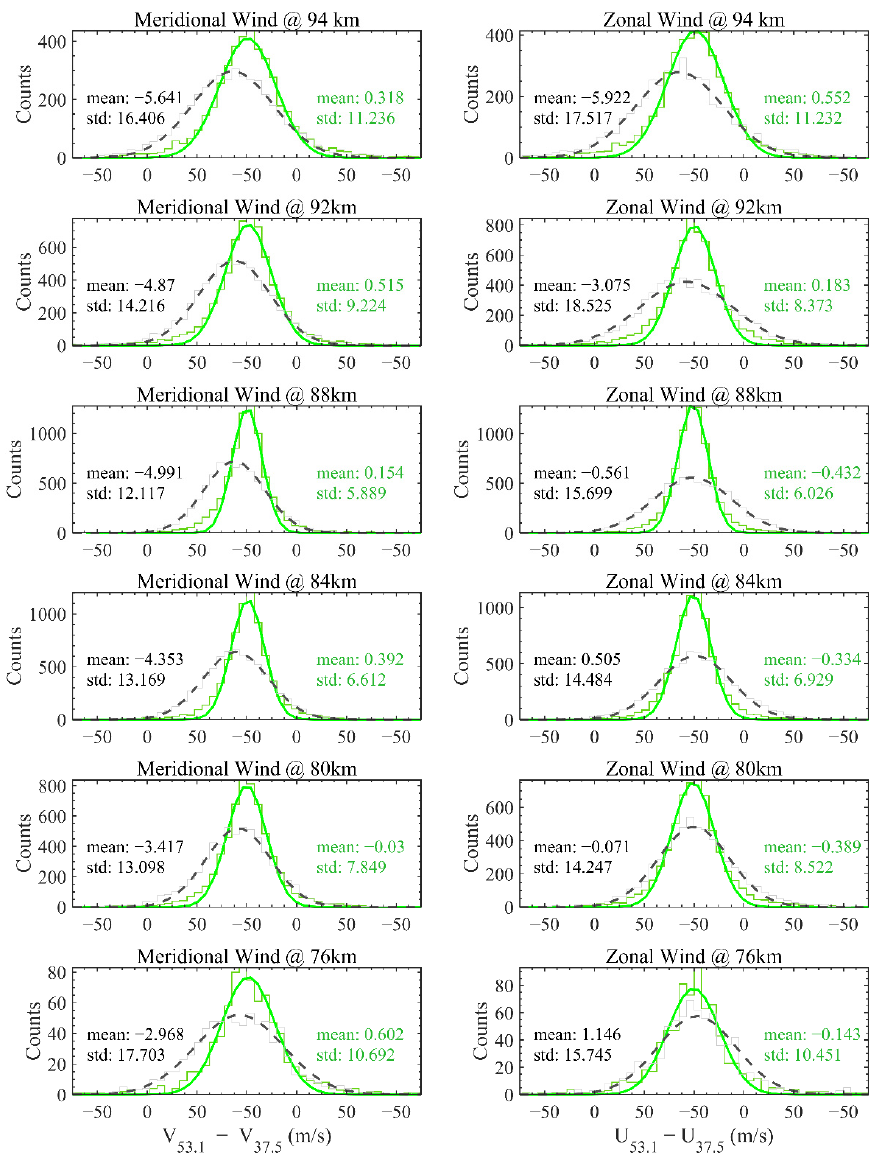
Figure 9. Histograms of the differences in the meridional and zonal wind velocity estimates at 76–94 km between the 53.1 MHz and 37.5 MHz MRs before (black) and after (green) applying the angular correction. The smoothed curves represent Gaussian distributions with the fitted mean and variance, and the mean and standard deviation are labeled.